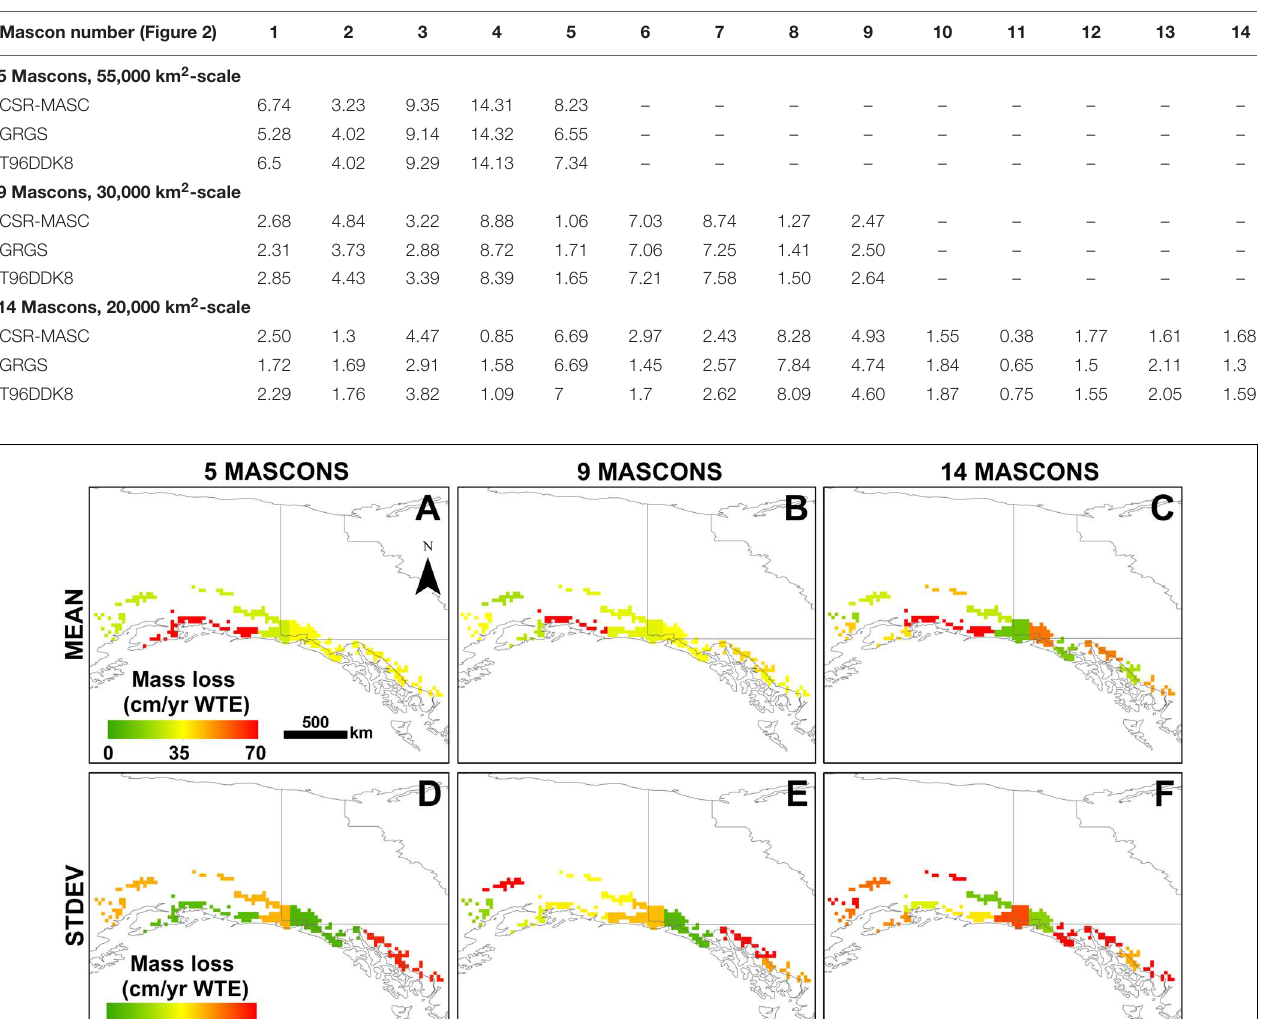
TABLE 5 | Mass losses measured in each mascon in Gt/year.